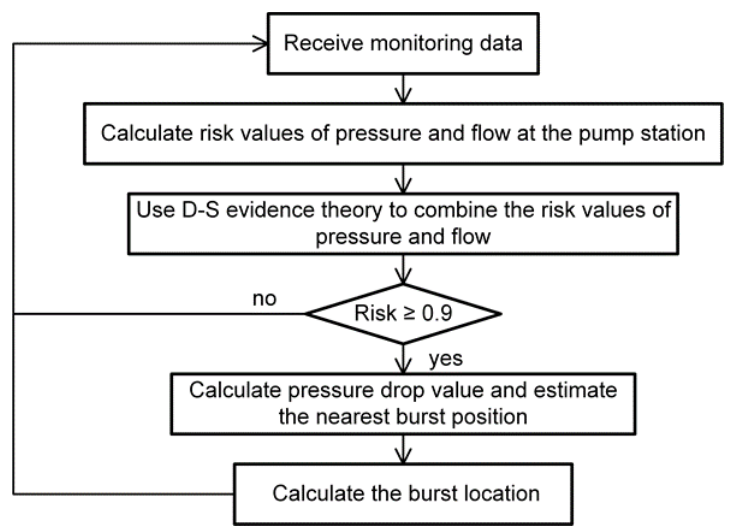
Figure 11. Flowchart of pipe burst monitoring system.